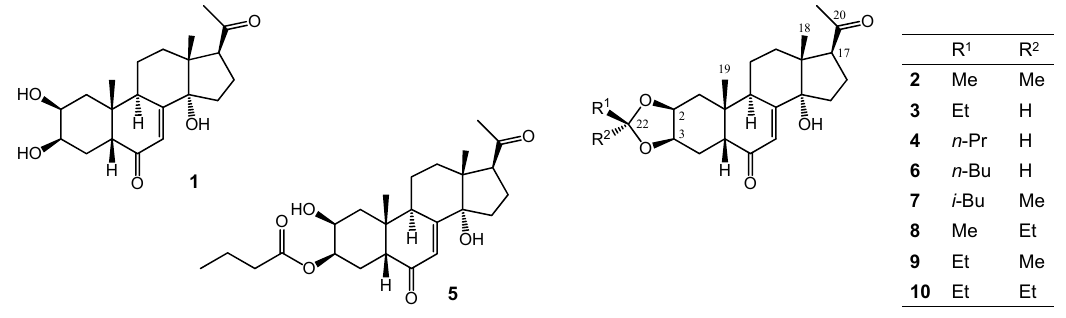
Figure 1. Chemical structures of compounds 1 – 10 .